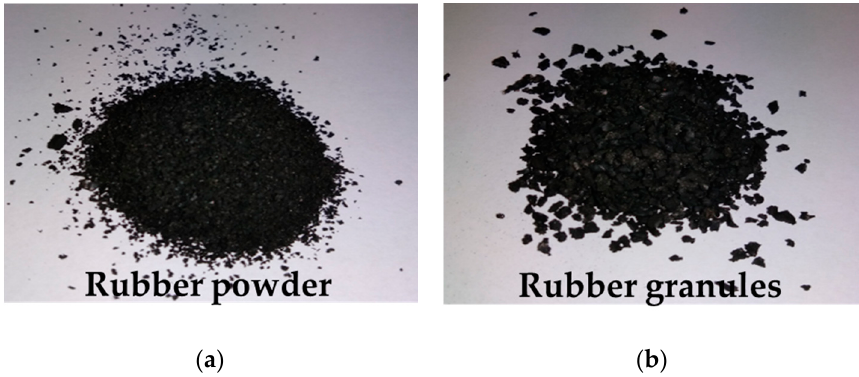
Figure 7. Size and shape of GTR powder ( a ) and granules ( b ) used in the research work .